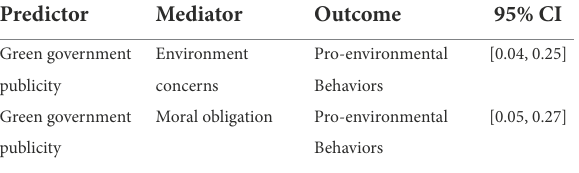
TABLE 4 Results of mediating